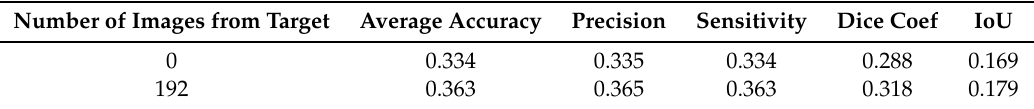
Table 4. Segmentation Accuracy, Precision, Sensitivity, Dice Coefficient and IoU score for different numbers of sampled images from the target domain (Vaihingen as source and Potsdam as target).